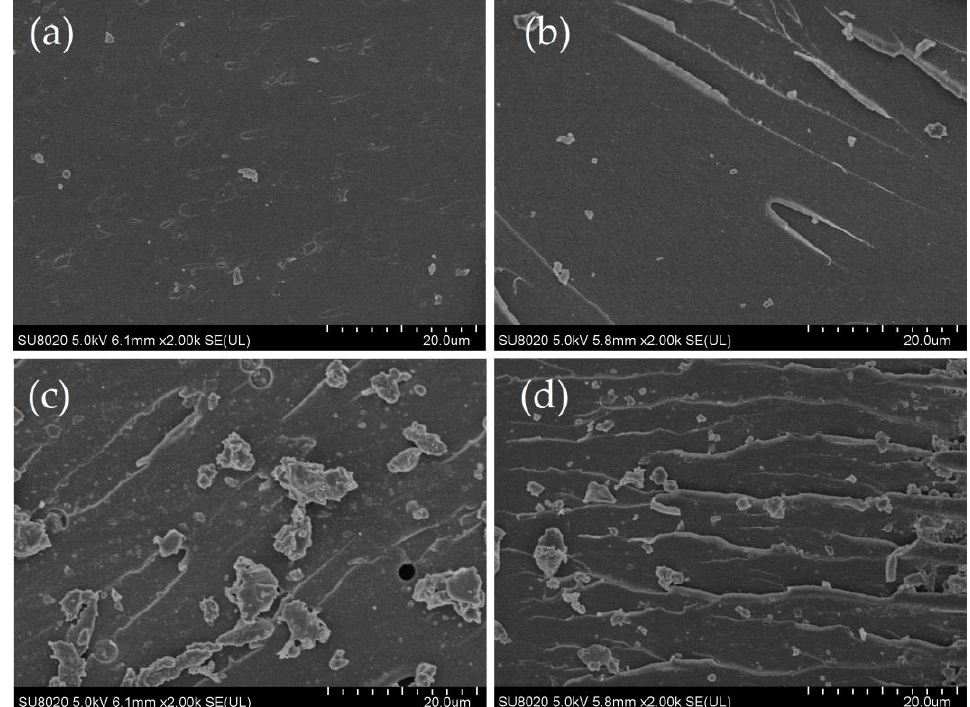
Figure 2. SEM images of brittle-fractured cross-sections of ( a ) CE, ( b ) CE/BMI, ( c ) CE/EP, and ( d ) CE/BMI/EP.